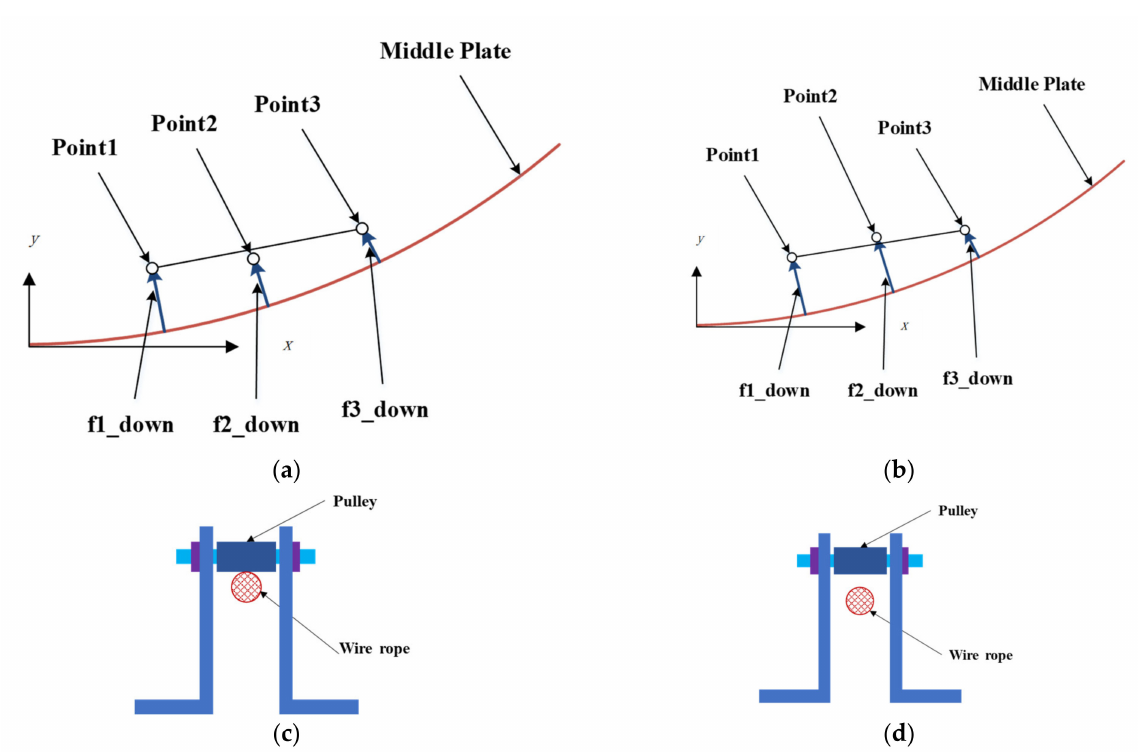
Figure 4. Relative position relationship between the rope and pulley: ( a ) f2_down exists; ( b ) f2_ down does not exist; ( c ) f2_down exists; ( d ) f2_down does not